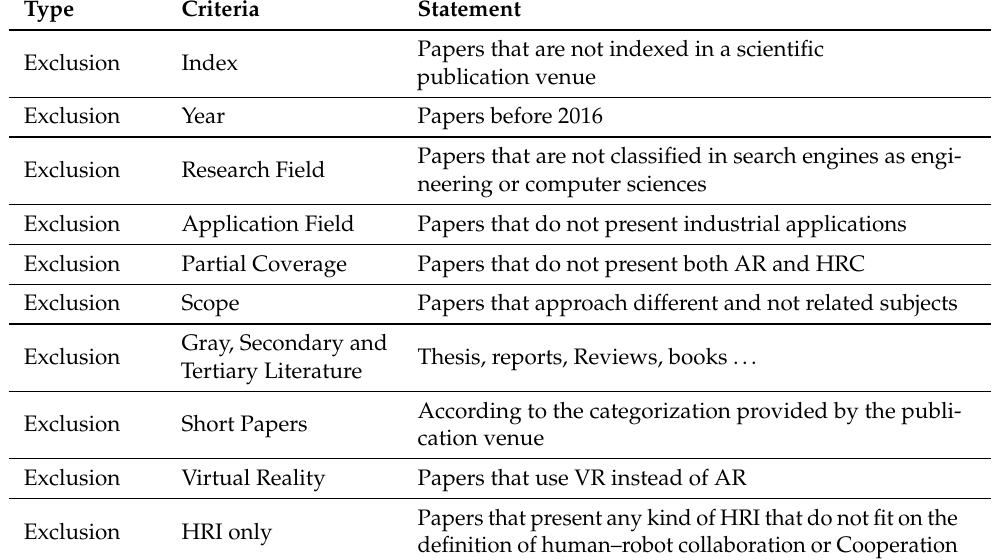
Table 4. Exclusion